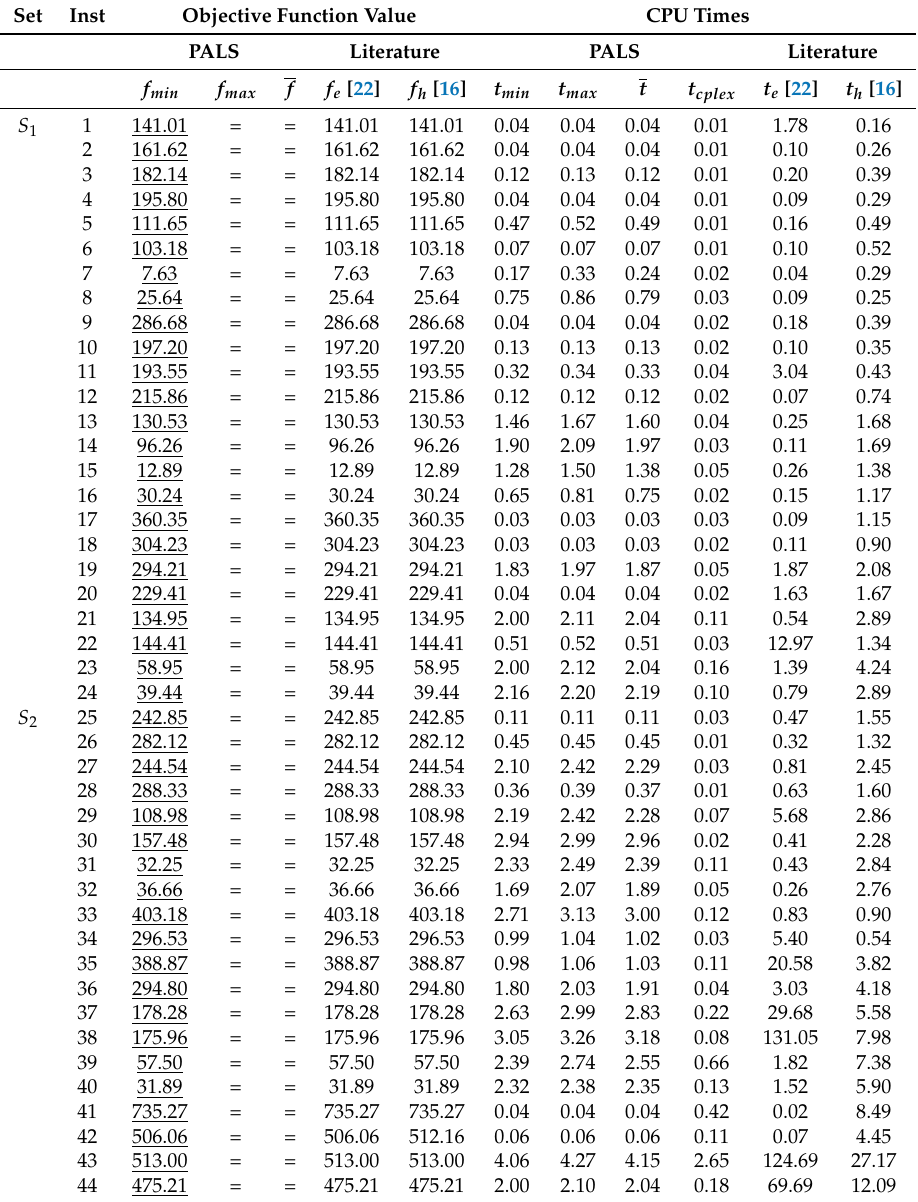
Table 1. Results of the benchmark